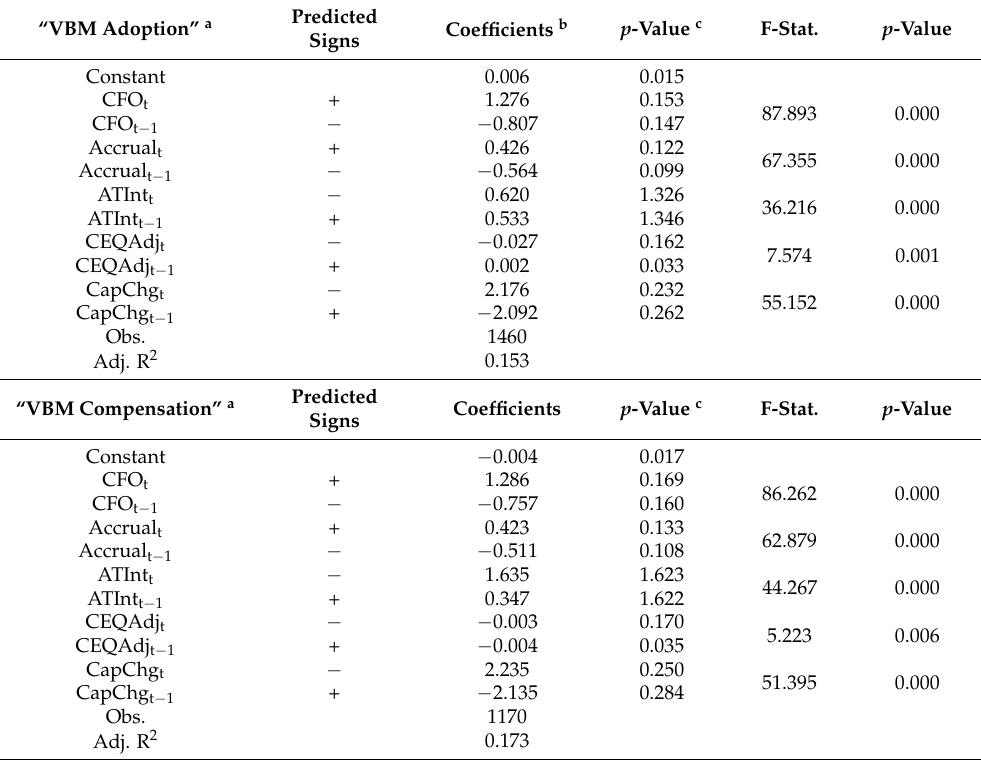
Table 5. Test for incremental information content of ERIC components among VBM adopters: Cash flow from operation, accruals, after-tax interest expenses, certainty equivalent adjustments, and capital charge.